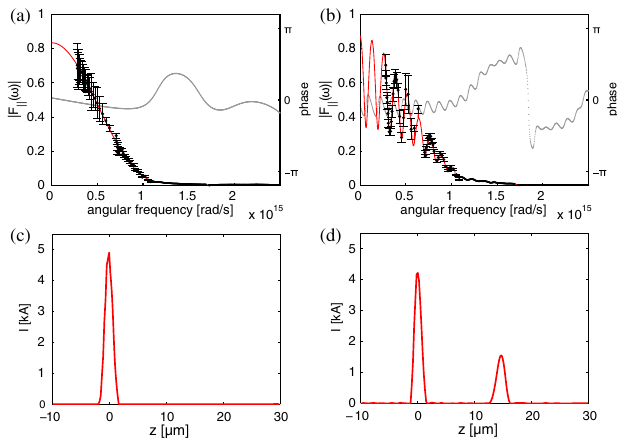
FIG. 2. Measured and reconstructed longitudinal form factor j F ð ω Þj and reconstructed bunch profiles I ð z Þ for 2 representative ∥ shots for gas cell lengths of 5 and 13 mm, respectively: (a,b) Measured (black) and reconstructed (red) CTR spectrum, and reconstructed spectral phase (grey); Error bars show the rms error of the mid-infrared spectrometer (due to readout noise, uncer- tainty in spectral response of individual pyro-electric detectors and transmission of the silicon wafer). (c,d) Reconstructed longitudinal bunch